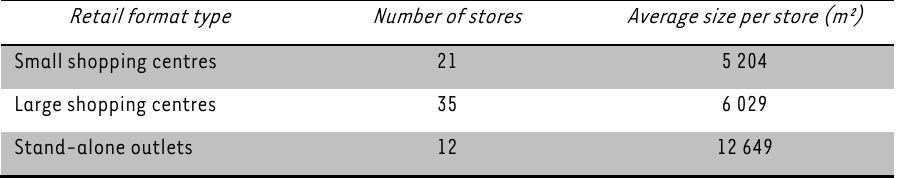
TABLE 2: Grouping of stores by retail format for sample Retail format